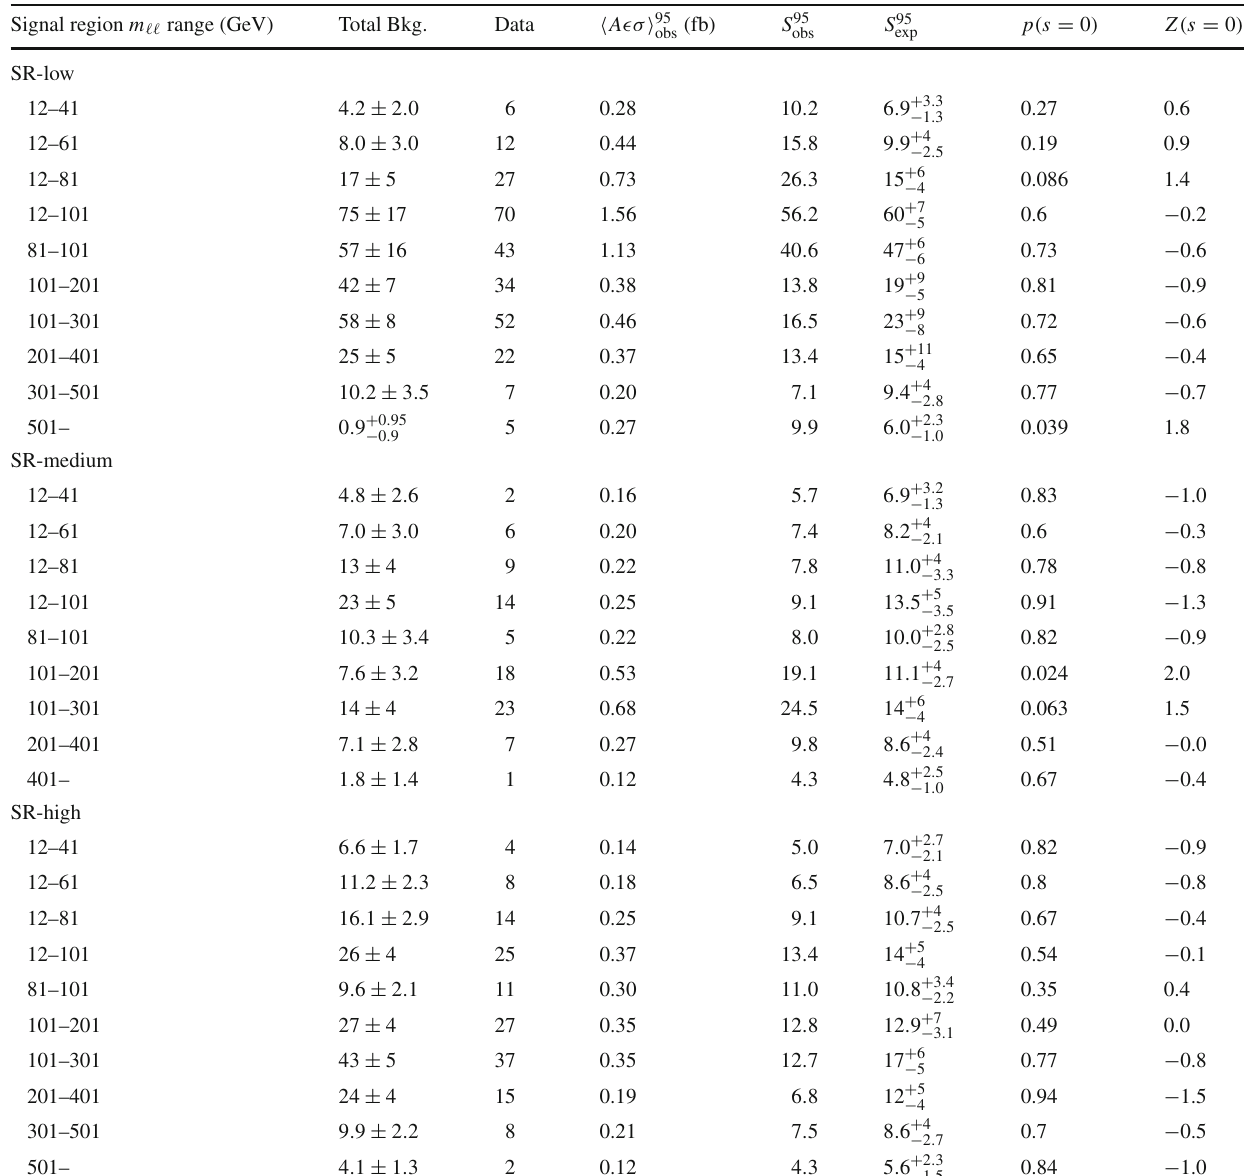
( (cid:11) A (cid:17)σ (cid:12) 95 ) and on the number of signal events ( S 95 ). The sixth column obs obs ( S 95 exp ) shows the expected 95% CL upper limit on the number of signal events, given the expected number (and ± 1 σ excursions on the expec- tation) of background events. The last two columns indicate the discov- ery p -value ( p ( s = 0 ) ), and the Gaussian significance ( Z ( s = 0 ) ). For cases where p ( s = 0 ) < 0 . 5 a negative significance is shown